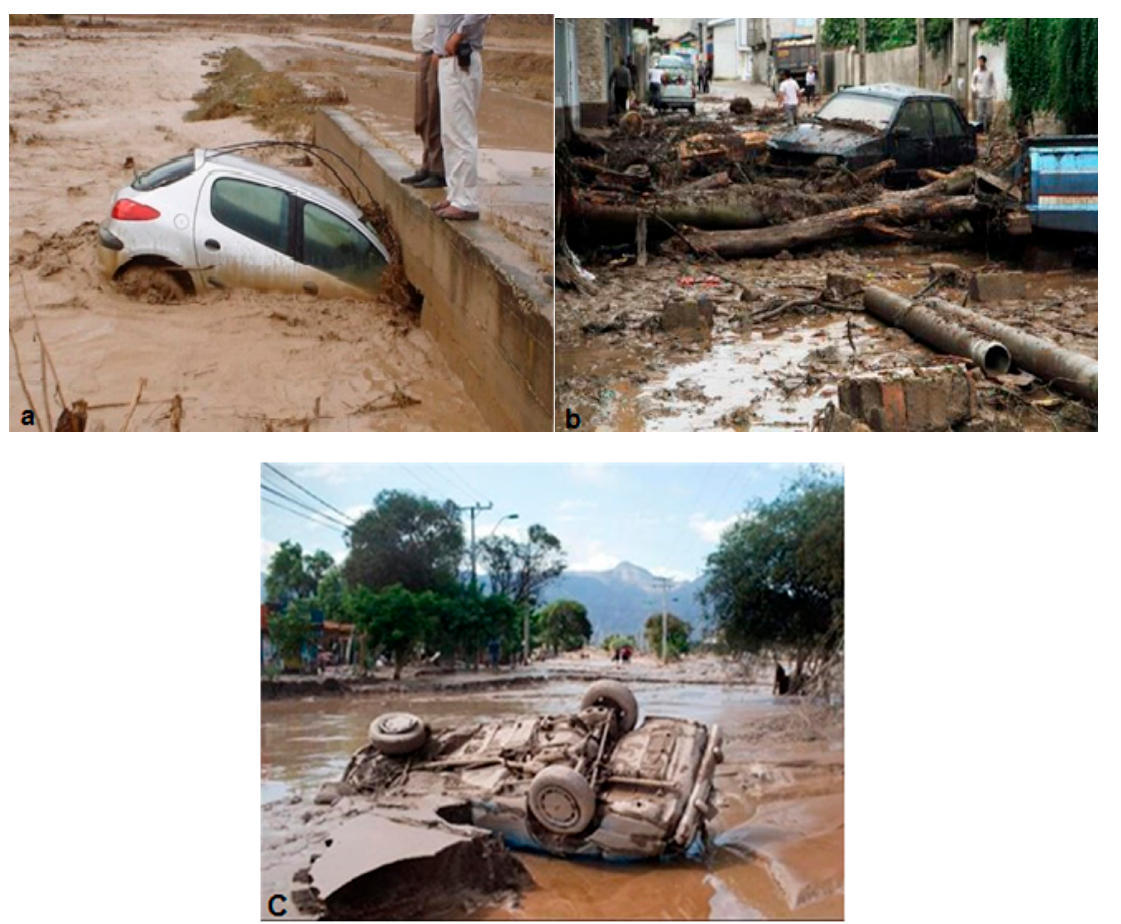
Figure 2. ( a ) Flood in Surkh Rod and Mahmoud Abad, on April 12, 2015, ( b ) flood in Neka on September 12, 2012, ( c ) flood in Behshahr on September 16, 2013.